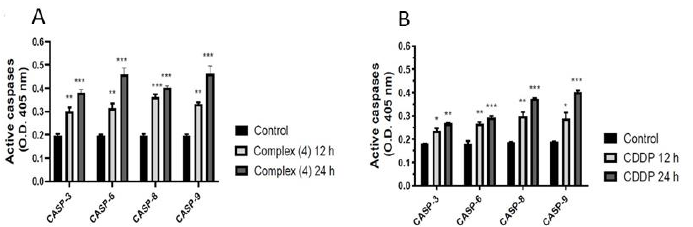
Figure 5. Determination of active caspases in MDA-MB-231 cells. Activation of caspases 3, 6, 8, and 9 was determined after 12 and 24 h of treatment with 2 × IC 50 of complex ( 4 ) or with cisplatin. ( A ) MDA-MB-231 cells treated with complex ( 4 ); ( B ) MDA-MB-231 cells treated with CDDP. Values are means ± SD from two independent experiments performed in triplicate. * p < 0.05, ** p < 0.01, and *** p < 0.001 versus untreated control.